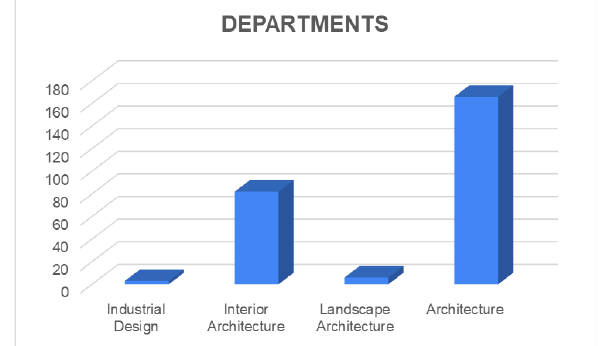
Figure 4. Department of Participants